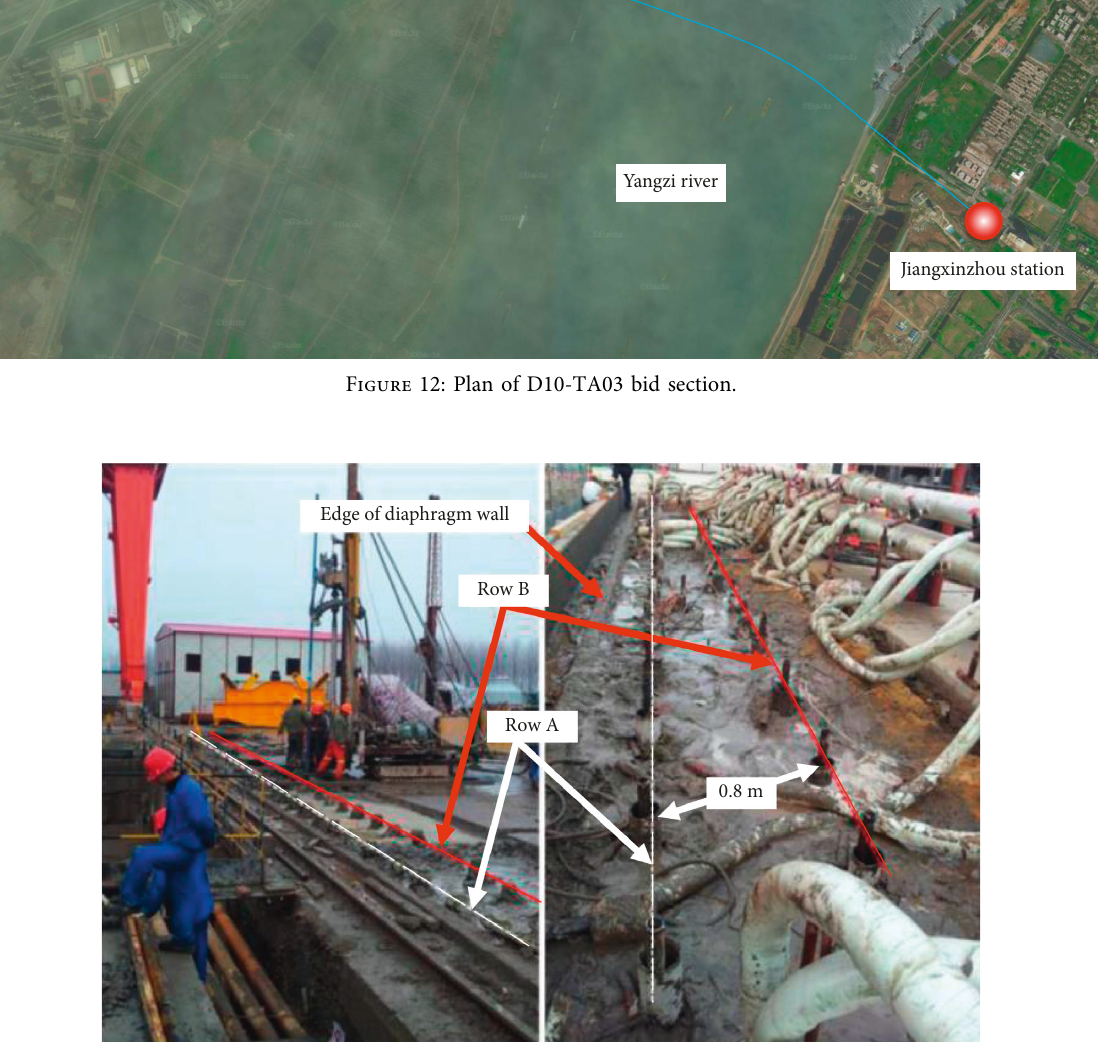
Figure 13: Site layout of vertical freezing